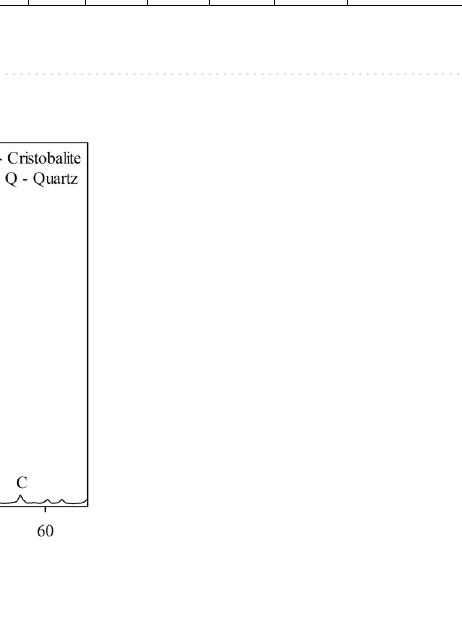
Figure 2. RHA mineralogical